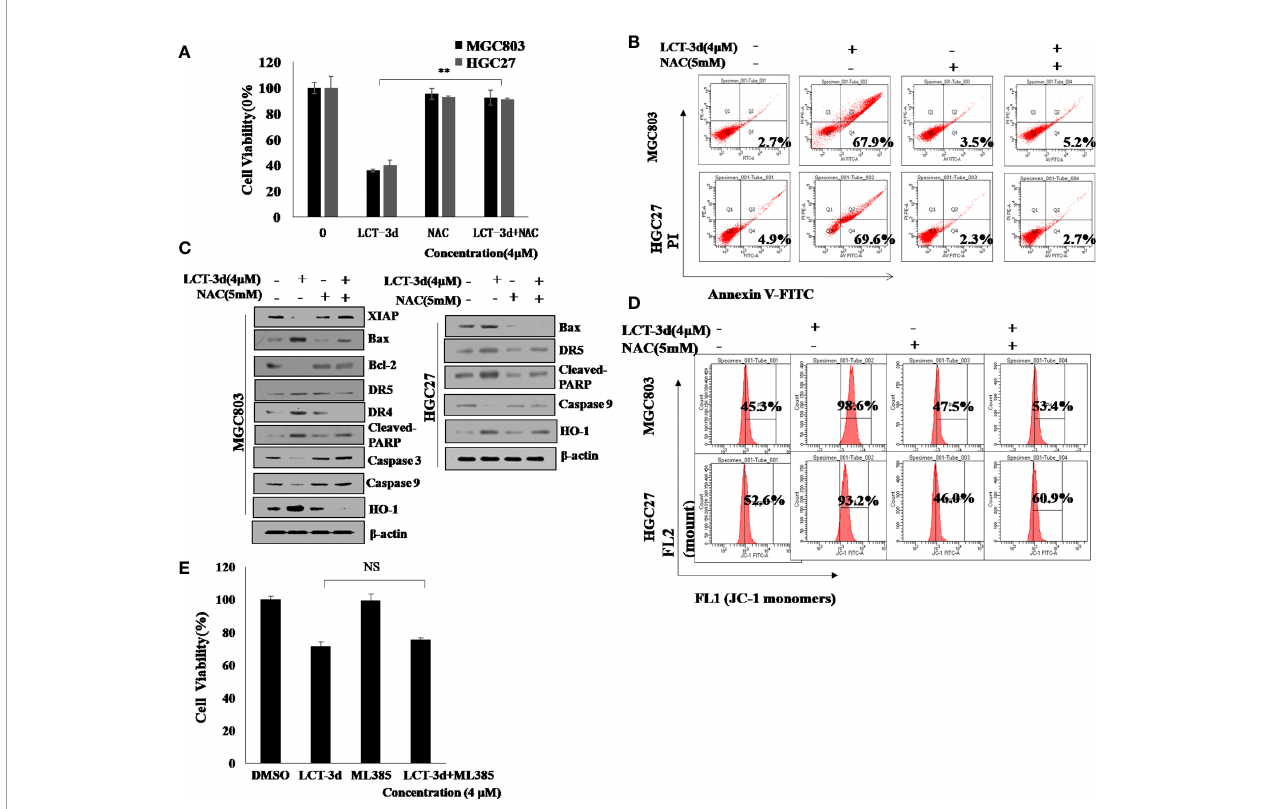
FIGURE 6 | LCT-3d-induced apoptosis is associated with the rising ROS in gastric cancer cells. (A) MGC803 cells and HGC27 cells were pretreated with NAC (5 mM) for 1 h, followed by incubation with LCT-3d (4 m M) for 48 h. The effect of NAC on LCT-3d-induced cell death was analyzed by MTT assay. **P < 0.01, signi fi cantly different compared with control. (B) Flow cytometric analysis demonstrated the effects of NAC (5 mM) on LCT-3d (4 m M)-induced cell apoptosis of the gastric cancer cells. (C) Western blotting assay showed the effect of NAC (5 mM) on LCT-3d (4 m M)-induced change of protein expression at 48 h. (D) Flow cytometric analysis showed the effect of NAC (5 mM) on LCT-3d (4 m M)-induced loss of MMP ( DY ) in gastric cancer cells. (E) MGC803 cells pretreated with ML385 for 1 h followed by the treatment with LCT-3d (4 m M) for an additional 48 h. The pretreatment with ML385 rarely reversed the cell death in MGC803 and HGC27